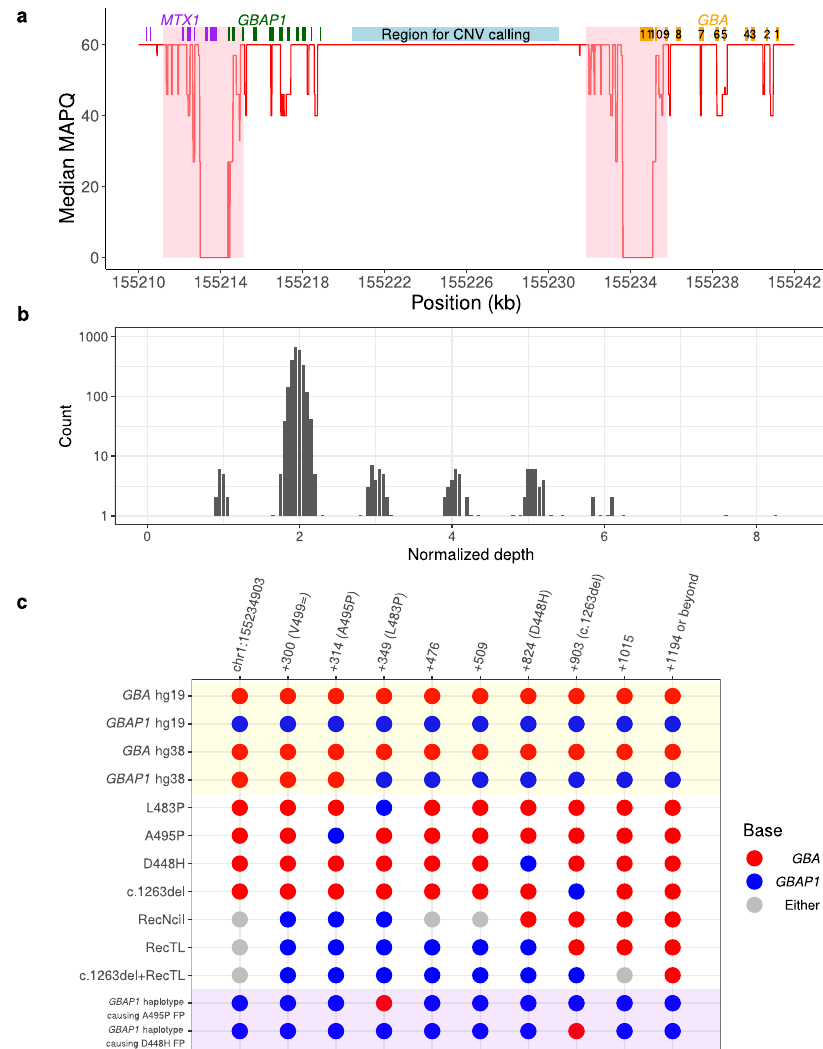
Fig. 2 Gauchian detects challenging GBA variants through targeted copy number calling and haplotype phasing. a Median mapping quality (red line) across 2504 1kGP samples plotted for each position in the GBA / GBAP1 region (hg38). A median fi lter is applied in a 50 bp window. The eleven exons of GBA are shown as orange boxes. GBAP1 and MTX1 exons are shown as green and purple boxes, respectively. The 4 kb major homology region (98.1% sequence similarity, exons 9 – 11) between GBA and GBAP1 is shaded in pink and highlights an area of low mapping accuracy. The light blue box shows the 10 kb unique region between the two genes in which copy number calling is performed in Gauchian. b Distribution of normalised depth in the 10 kb CN calling region in 2504 1kGP samples, showing peaks at CN1 (CNL), 2 (no CNV) and 3-8 (CNG). c Recombinant haplotypes in the exons 9 – 11 homology region, distinguished by GBA / GBAP1 differentiating bases (x-axis). Reference genome sequences are shaded in yellow. There is an error in hg38 where the fi rst three sites of GBAP1 show GBA bases, which could lead to alignment errors. The GBA recombinant haplotypes are shown in the white background, including those where one or a few nearby sites are mutated to the corresponding GBAP1 base, resulting from either gene conversion or CNL. Grey bases indicate that the base can be either GBA or GBAP1 depending on the breakpoint position of the CNL/conversion. Shaded in purple are two example GBAP1 haplotypes, found by Gauchian, that have been partially converted to GBA and can cause false-positive GBA variant calls by standard secondary analysis pipelines. For the fi rst example, the reverse-p.L483P variant on GBAP1 directs aligners to align GBAP1 reads to GBA , causing the nearby p.A495P false- positive call. For the second example, the reverse-c.1263del variant inserts 55 bp to GBAP1 , driving GBAP1 reads to align to GBA , causing the